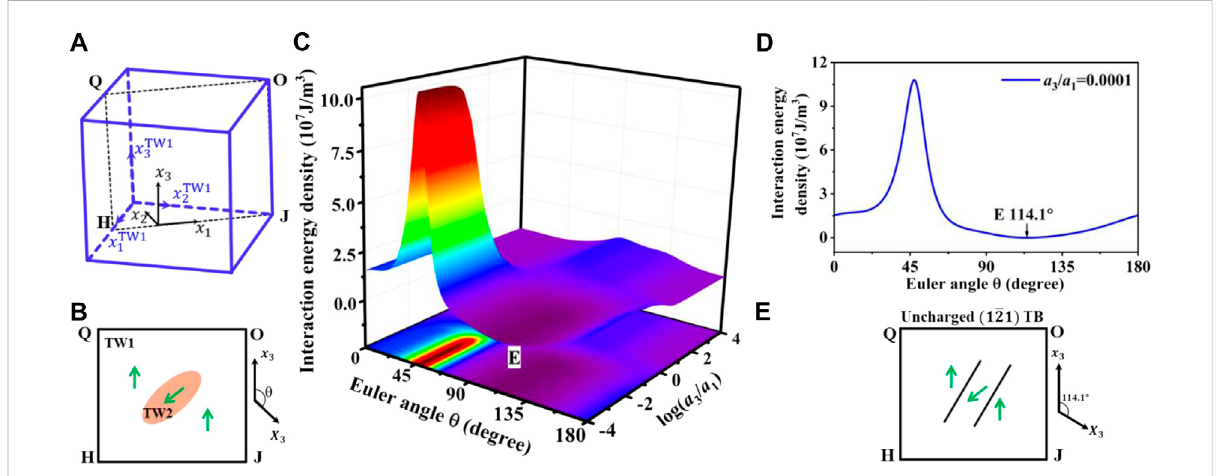
FIGURE 6 Energetic analysis of twinned structure with variants ( ε S − TW1 5 , P S − TW1 5 ) and ( ε S − TW2 1 , P S − TW2 1 ) : (A) Schematic of the relationship between the global coordinatesystem x 1 x 2 x 3 andlocalcoordinatesystem x TW1 1 x TW1 2 x TW1 3 ; (B) Schematicofvariant ( ε S − TW2 1 , P S − TW2 1 ) asaninhomogeneousinclusionwithin ) as the matrix; (C) the potential energy variation as a function of the shape aspect ratio a the variant ( ε S − TW1 5 , P S − TW1 5 inhomogeneous inclusion TW2; and (D) the corresponding potential energy variation at a 3 / a 1 = 0.0001; The schematic of the uncharged (E) twin boundary corresponding to the well in the energy